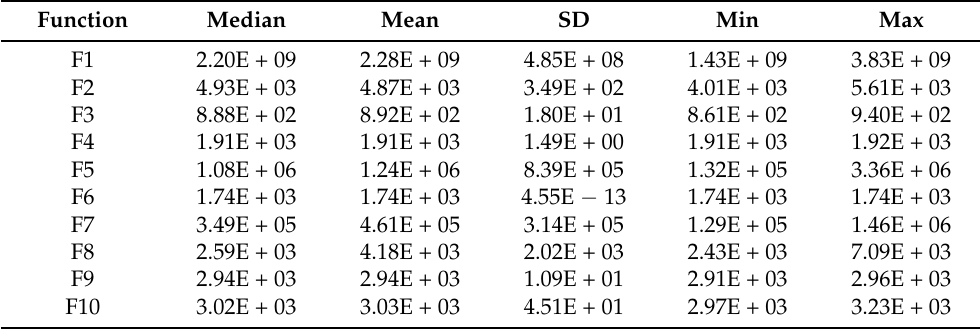
Table 5. The CEC 2020 ( D = 20) function values achieved by Jaya over 50 runs and 50,000 func- tion